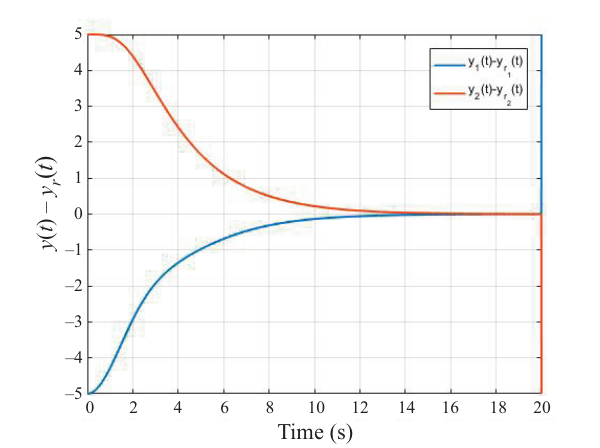
Figure 2. Output error y ( t ) − y Fig. 2.